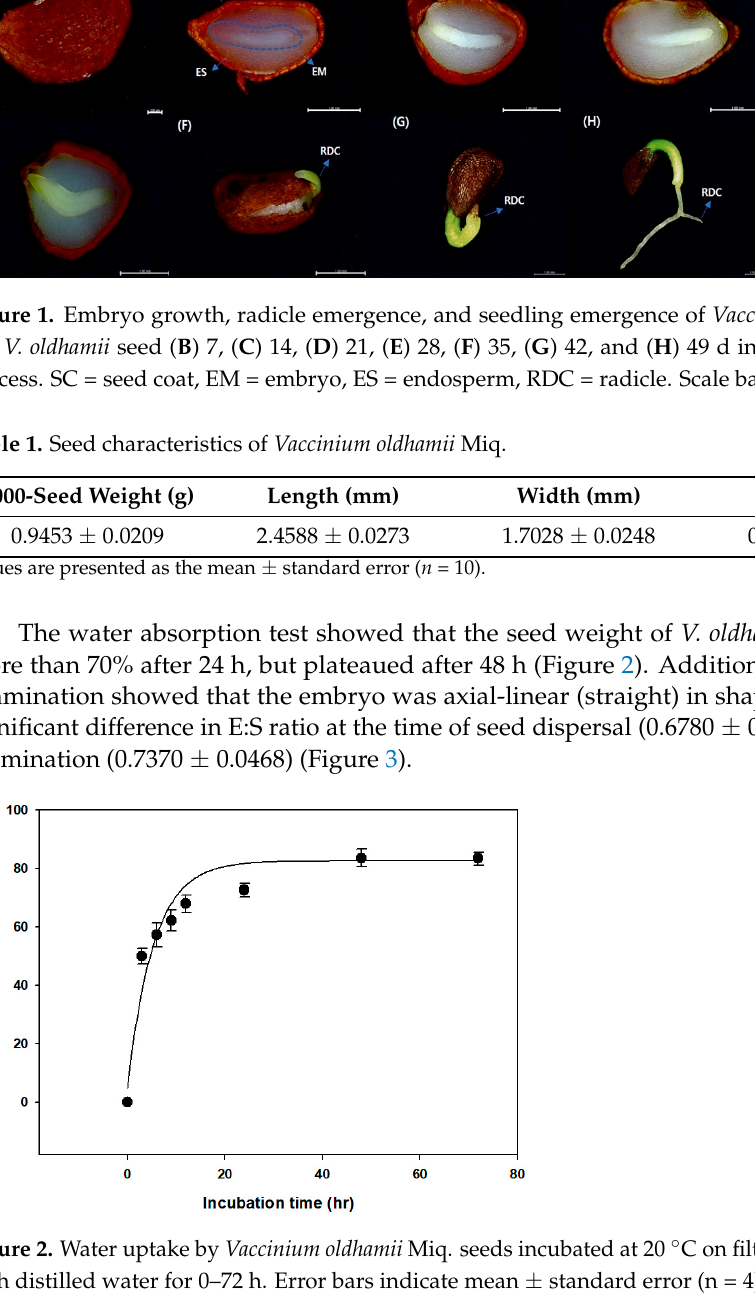
Figure 3. Embryo to seed (E:S) ratio of Vacinnium oldhamii at dispersal and before germination, Error bars indicate the mean ± standard error (n = 10). Each E:S ratio at dispersal and prior to germination was compared using a paired t-test (NS: no significant). 3.2. Seed Germination The results of the x-ray analysis showed that the filled percentage of the seed was 49.00 ± 3.0%. It can be confirmed that the progression pattern is being developed through Figure 1. Additionally, the germination of the seeds at 15, 20, 25, 25/15, and 15/6°C was 0.0, 6.0, 6.0, 20.0, and 0.0%, respectively (Figure 4), indicating that 25/15°C temperature was most favorable for seed germination. Moreover, the MGT at 20, 25, and 25/15°C were 28.5, 46.08, and 41.18 d, respectively (Table 2). The T 50 at 20, 25 and 25/15°C were 28.35, 45.94, and 37.5 d, respectively.